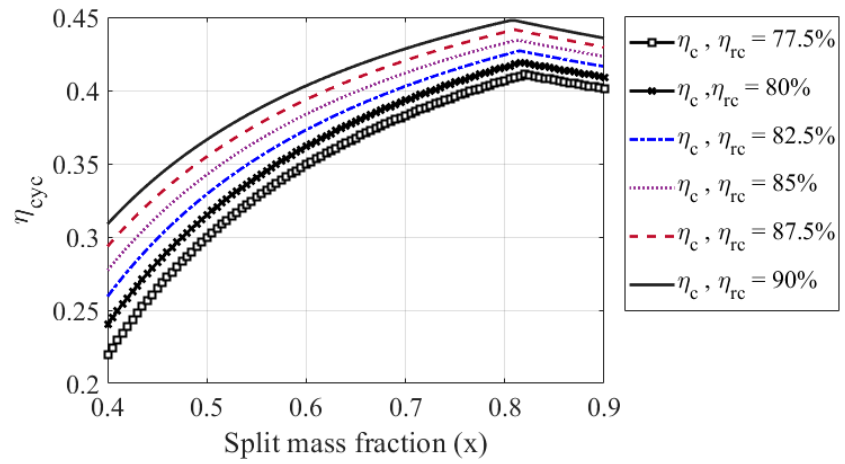
Figure 8. Impact of the compressor’s performance on the cycle’s efficiency.